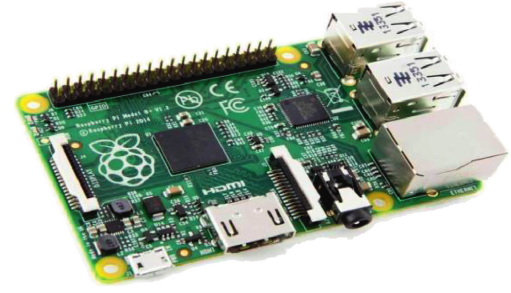
Figure 5: Raspberry Pi.